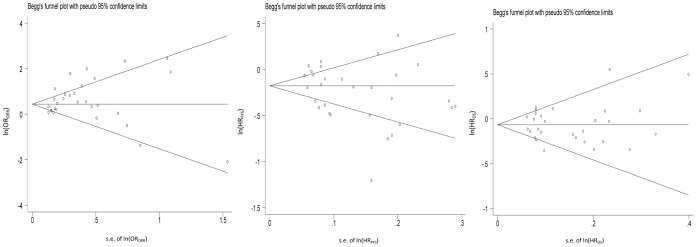
Begg's funnel plot.